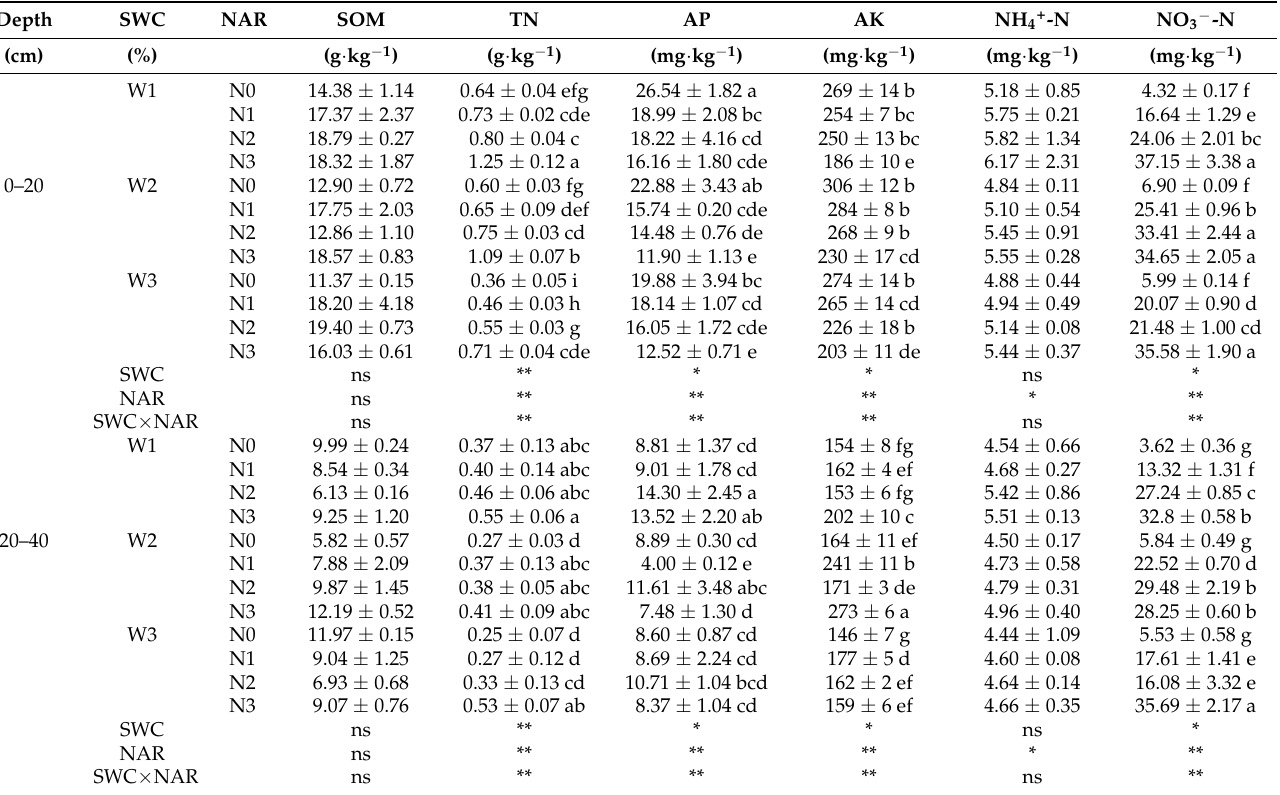
Table 2. Effects of soil water content and nitrogen application rates on soil nutrients in Populus tomentosa stands (2020).